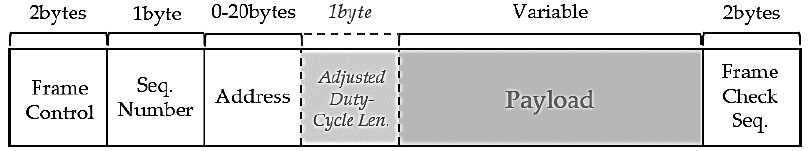
Figure 5. MAC Header (Data Unit) of ADX-MAC.